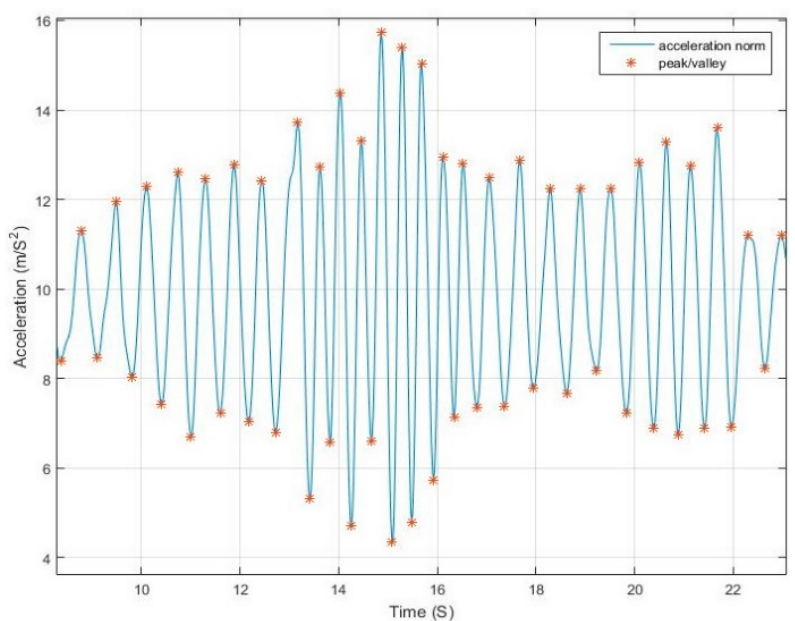
Figure 2. Walking with varying pace. Sensors 2017 , 17 , 2573